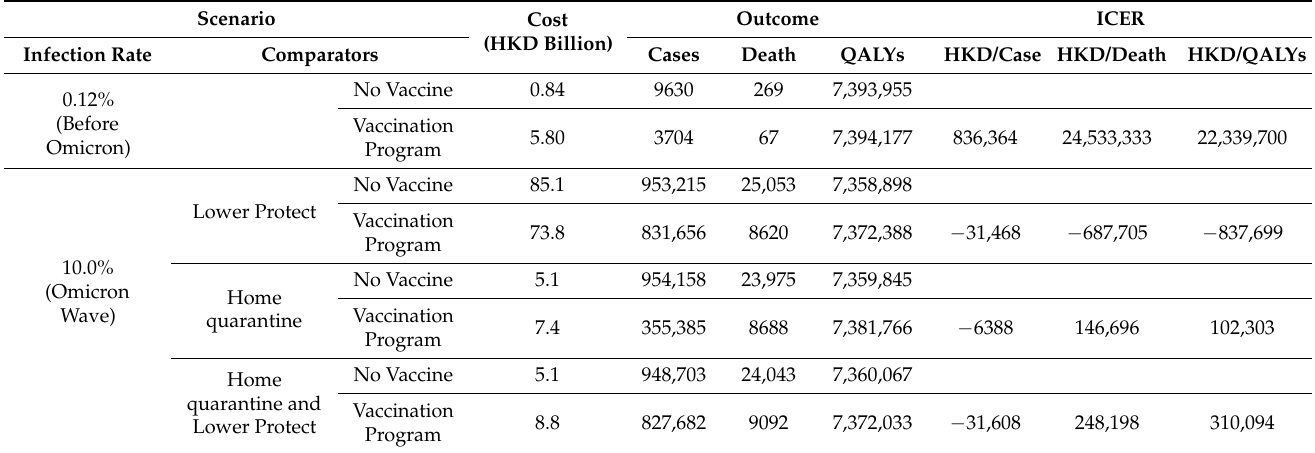
Table 2. Incremental cost-effectiveness ratio of the COVID-19 vaccination program in Hong Kong.